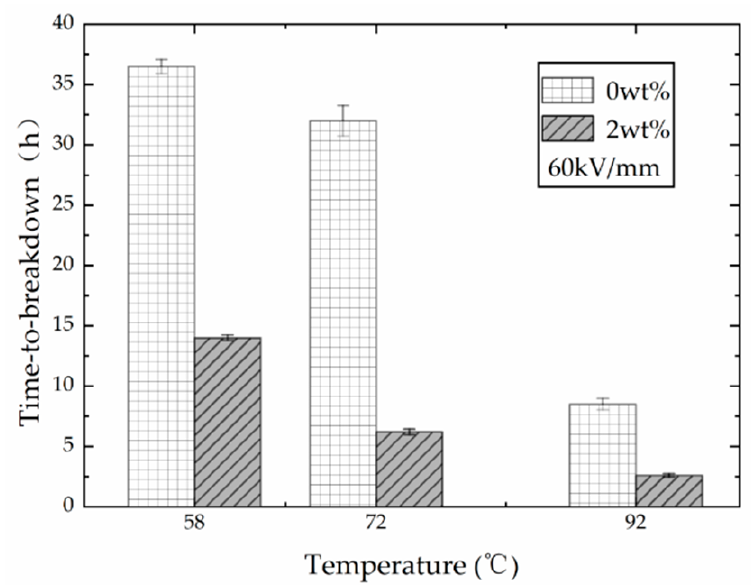
Figure 3. Time-to-breakdown vs temperature at a fixed electric field intensity. Due to the symmetrical molecular structure, the crystallinity of isotactic PP is